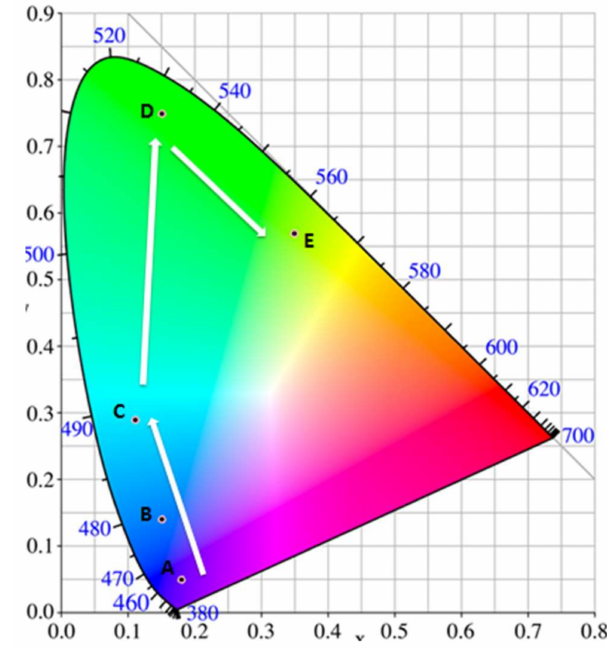
Figure 7. CIE chromaticity diagram of {Zn-M-BTC}{Cation} MOF system: (A) {Zn-Ni-BTC}{Me 2 NH 2+ }; (B)